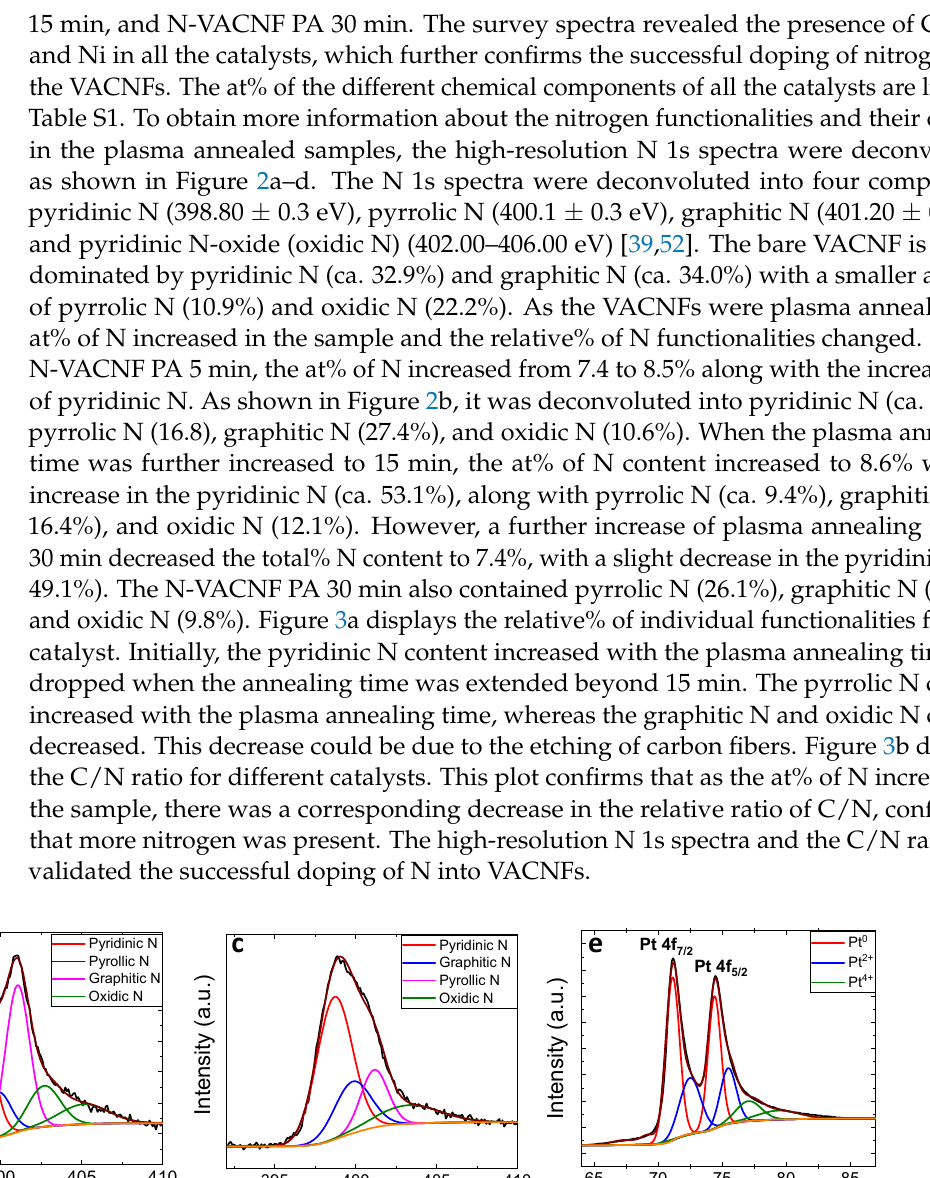
Figure 3. ( a ) Atomic% of different types of nitrogen, ( b ) ratio of C to N, and ( c ) atomic% of different types of oxygen in bare VACNF and VACNF samples plasma annealed for different time intervals. Figure S7 presents the O 1s spectra of bare VACNF, N-VACNF PA 5min, N-VACNF PA 15 min, and N-VACNF PA 30 min. As the plasma annealing time increased, O at% increase in the sample. The O 1s spectra of bare VACNF can be deconvoluted into four different peaks with binding energies (BE) of 531.28, 532.26, 533.64, and 534.72 eV corre- sponding to the C=O, C-O, C-O-H/C-O-C bonds, and physisorbed water, which accounted for 20.7, 47.7, 23.0 and 8.6% of total oxygen atoms, respectively [53]. After plasma anneal- ing, the N-VACNF samples showed C=O, C-O, and C-O-H/C-O-C peaks at almost the same binding energy with a small change in their relative% between samples. However, all three plasma-annealed samples had an additional peak at ~529.60 eV, which can be ascribed to the Ni-O bond [54]. This further confirmed the presence of NiO particles on the surface of VACNFs. The relative% of NiO was found to be 10.3, 15.0, and 16.4 for N- VACNF PA 5min, N-VACNF PA 15 min, and N-VACNF PA 30 min, respectively. Figure 3c illustrates the total O content and % of different oxygen species present in all four cat- alysts. Table S2 summarizes the BE and the relative area% of the individual chemical com- ponents derived from O 1s and N 1s high-resolution spectra for all the prepared samples.